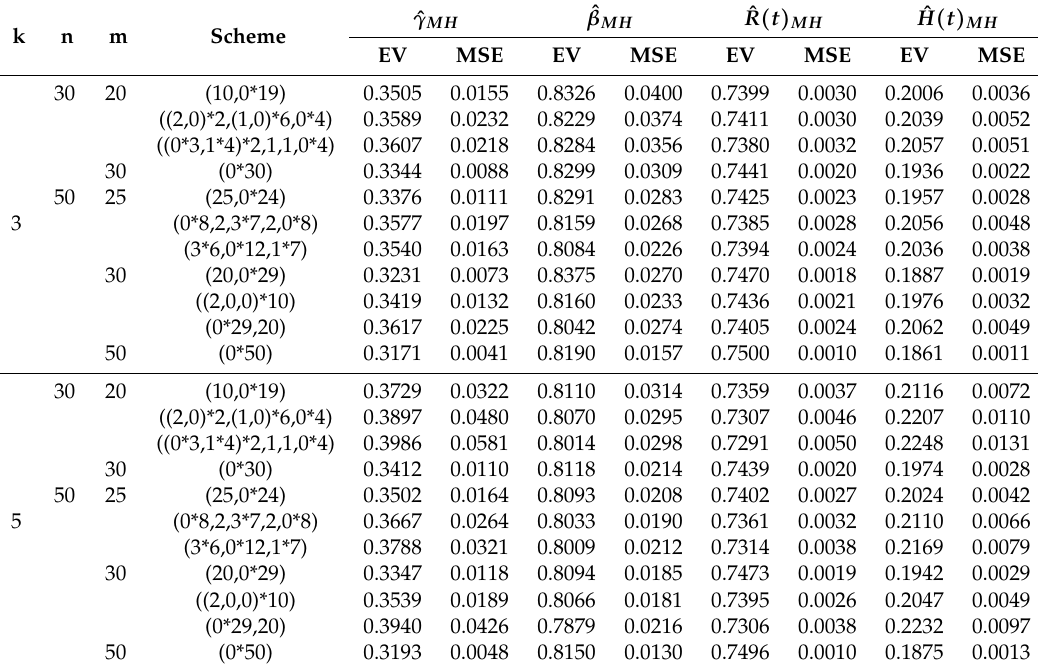
Table 14. Estimation values and MSEs of parameters, reliability and hazard functions using Metropolis-Hastings method under LLF when h = 0.5, γ = 0.3, β = 0.8, t = 1.5, a 1 = 1.08, b 1 = 3.6,